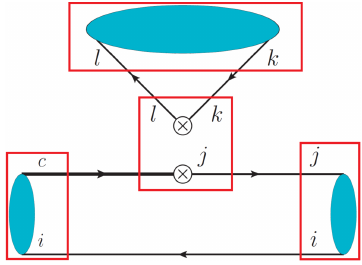
Figure 2 . Schematic description of the index-contraction of T